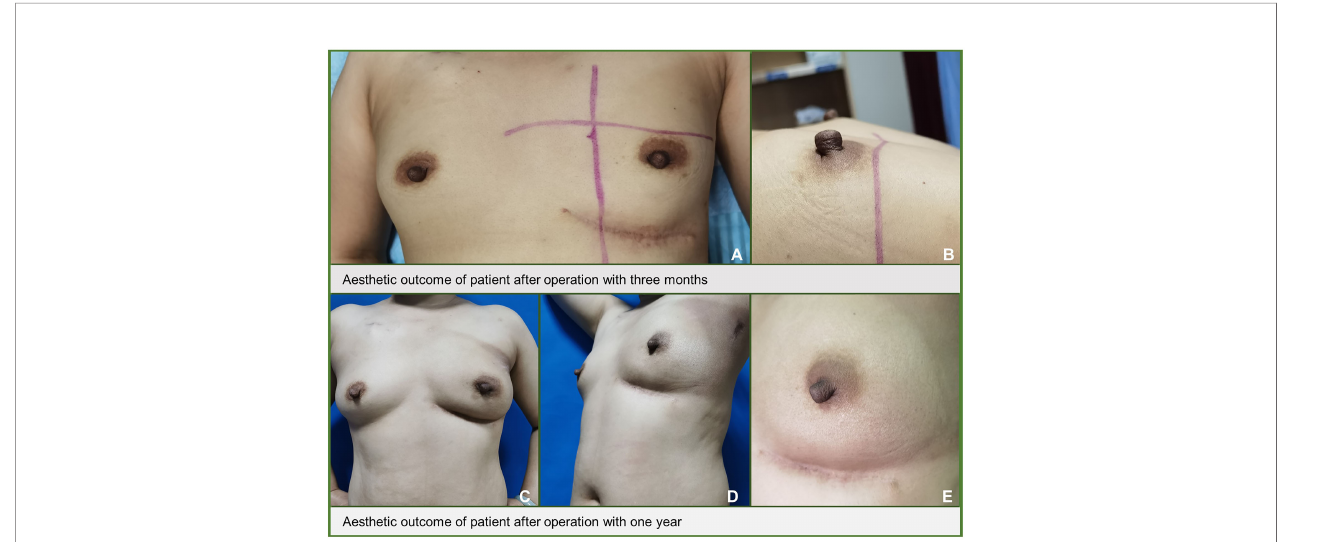
FIGURE 5 | The aesthetic outcome of the breast after